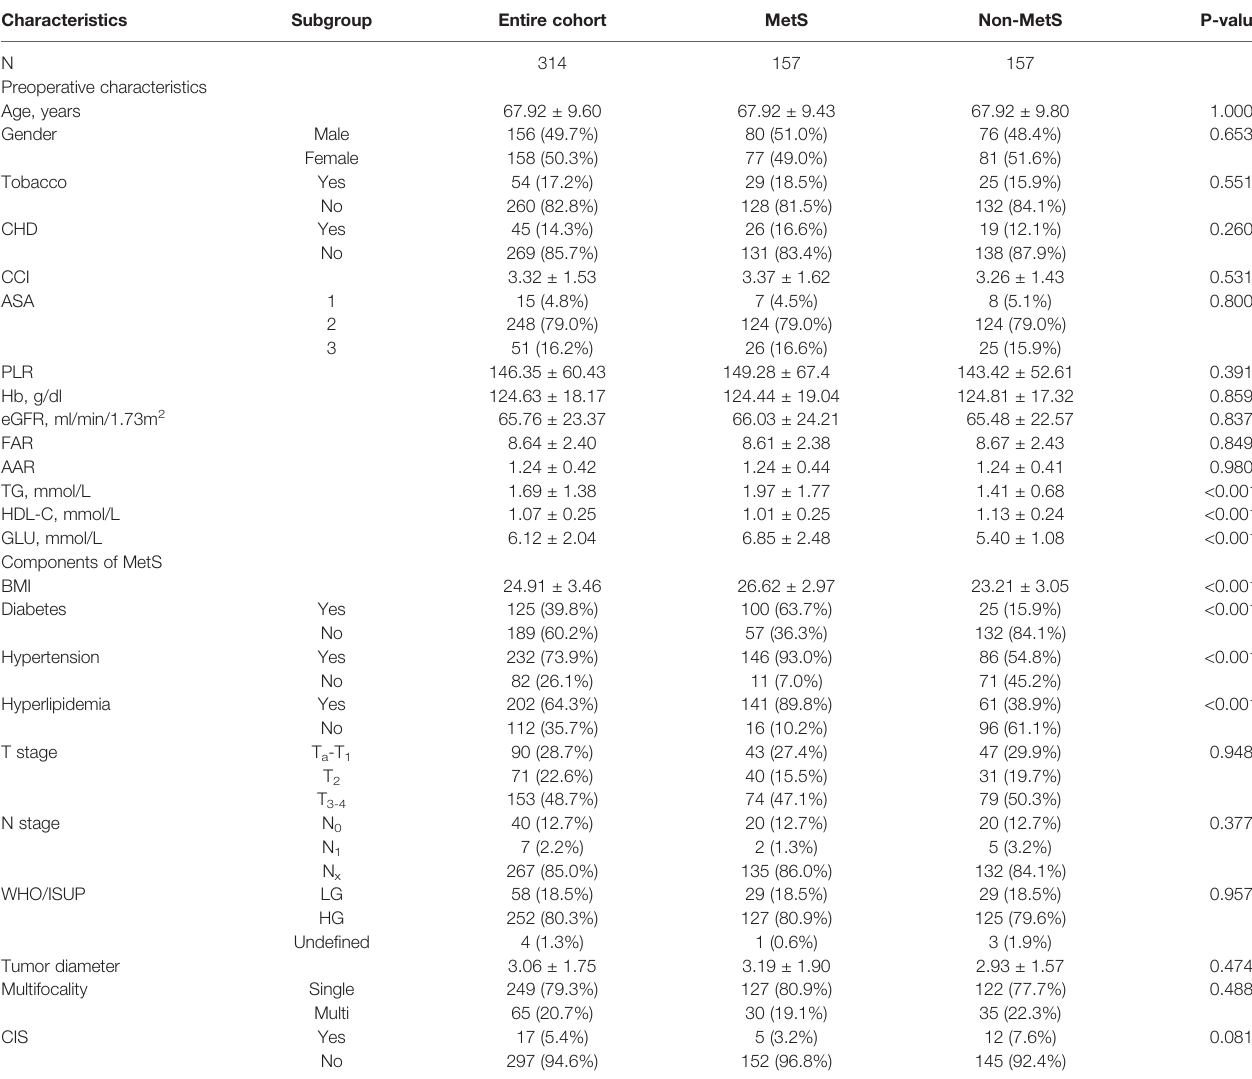
TABLE 3 | Clinicopathological characteristics of the entire cohort and subgroups according to MetS after propensity score matching.